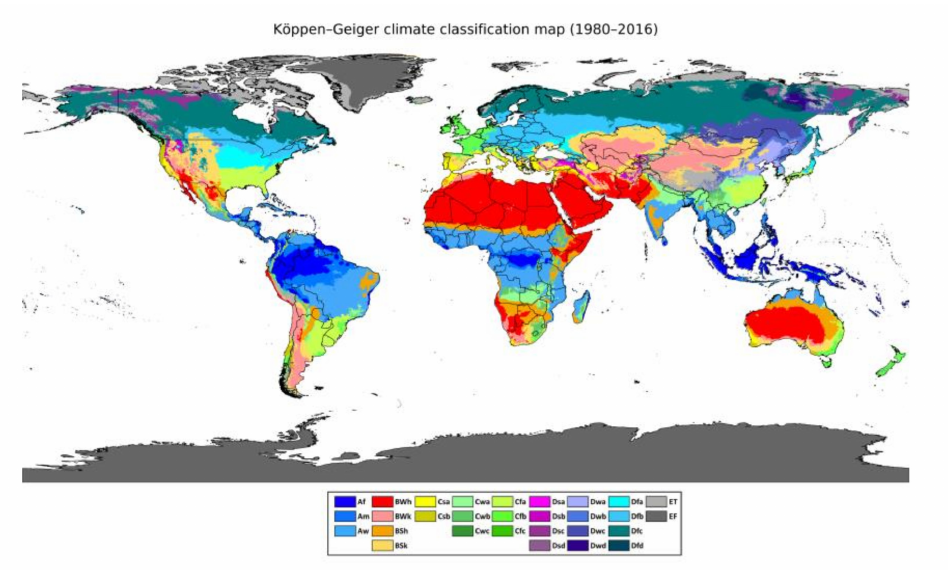
Figure 1. World climate map